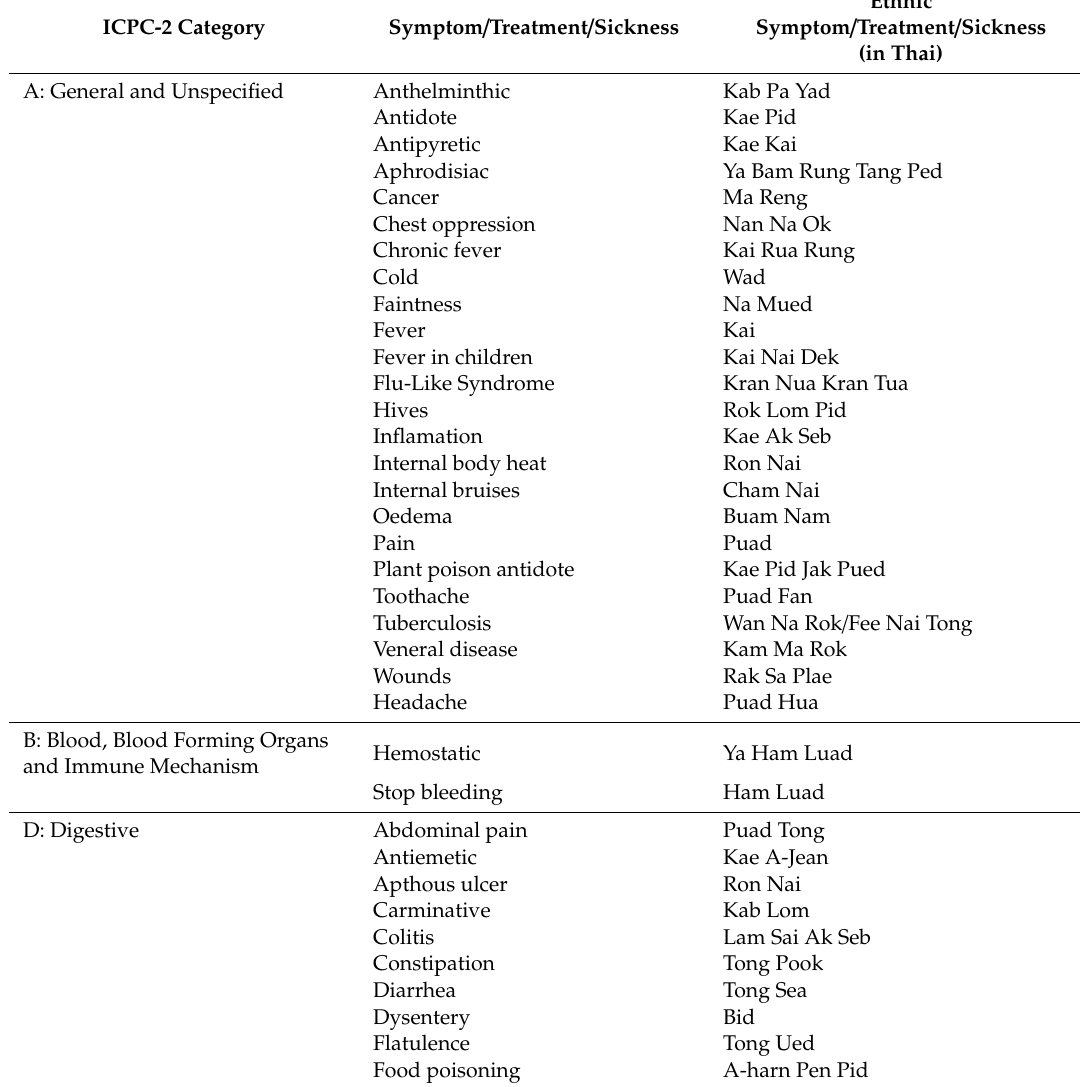
Table 4. List of ICPC-2 categories linked to symptoms / treatments / sicknesses translated from ethnic symptoms / treatments / sicknesses from the Thai